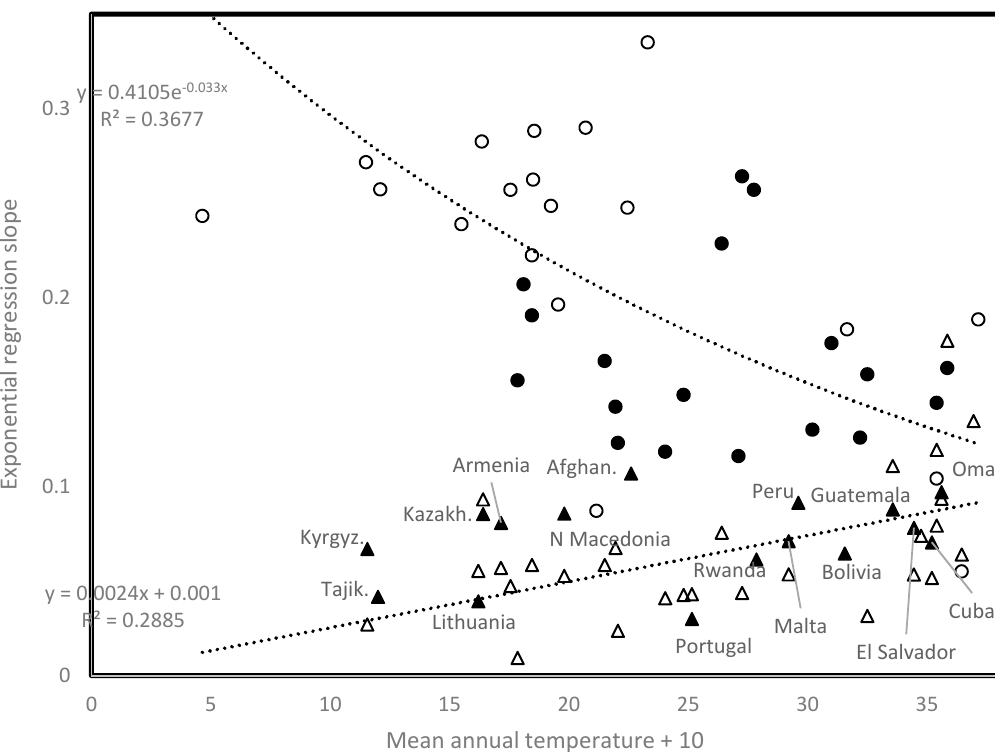
Figure 4. Slope of exponential regression of daily new cases vs. time, as a function of mean annual temperature, comparing trends for first wave slopes (open circles from [1], filled circles and filled triangles from the present study), and second wave slopes (open triangles). Data are from Table 1.